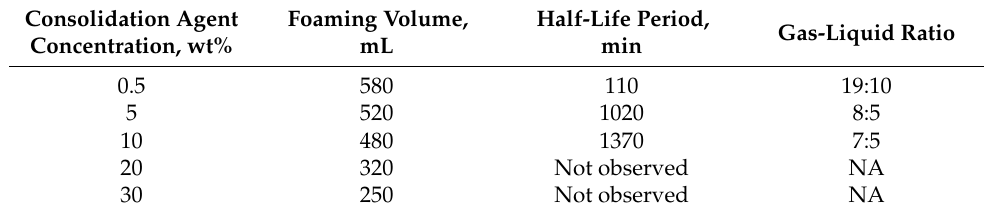
Table 4. Three-phase foam